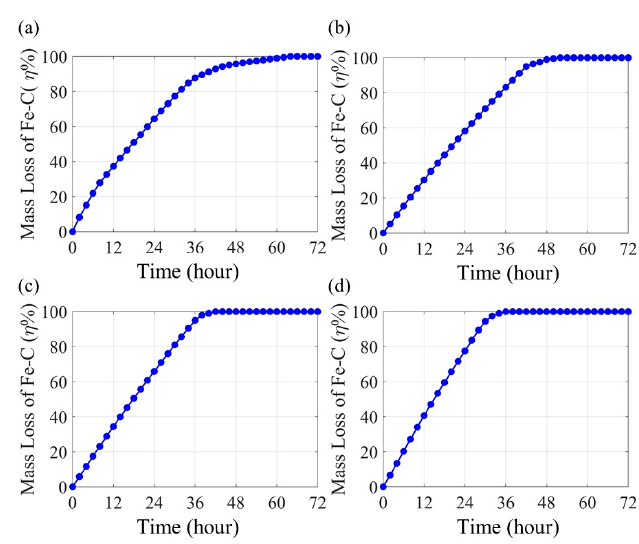
Figure 14. Fe-C mass loss over time at ( a ) 0, ( b ) 500, ( c ) 1000 and ( d ) 1500 µε .